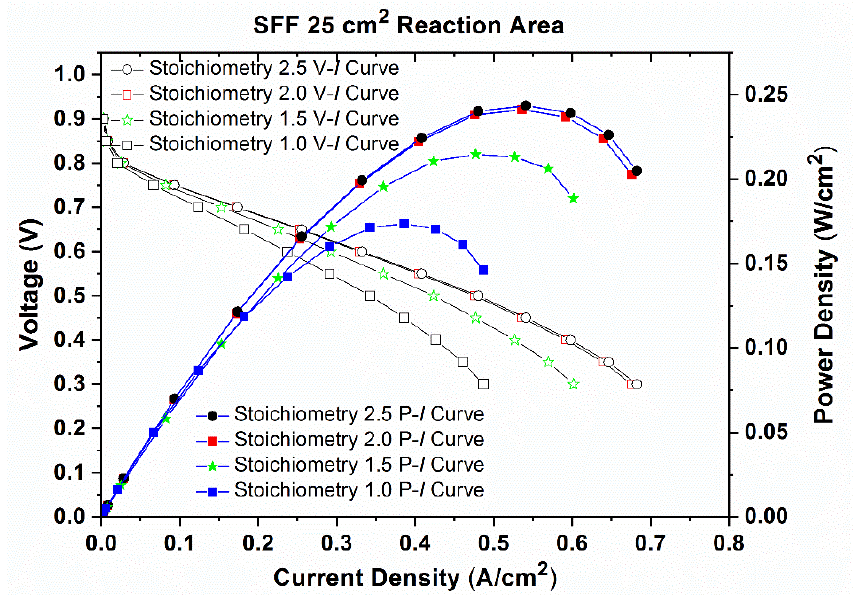
Figure 5. Performance (P–I) curves and Polarization (V–I) curves for SFF with 25 cm 2 reaction area for various stoichiometry values. Table 1. Increase in power density for various stoichiometry values on 25 cm 2 PEMFC with SFF. Stoichiometry